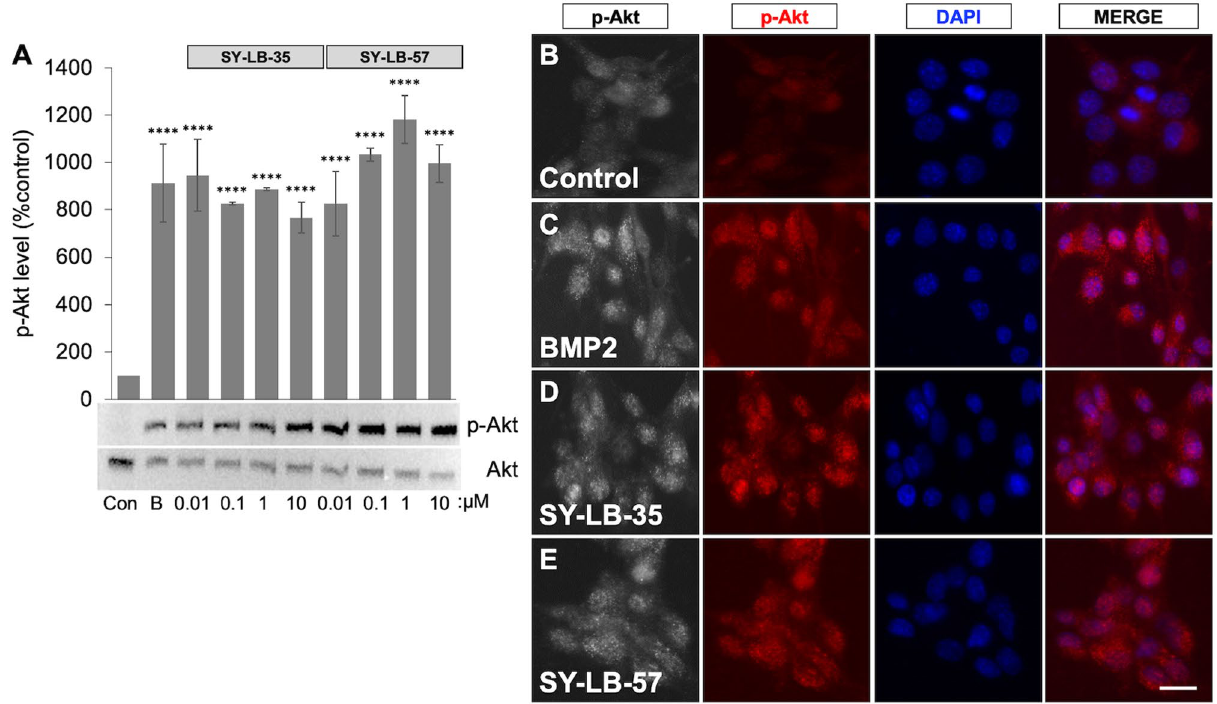
Figure 6. Phosphorylation and cytoplasmic distribution of p-Akt induced by SY-LB-35 and SY-LB- 57. (A ) Western Blot analysis using anti-p-Akt and anti-total Akt antibodies was performed on whole cell lysates of serum-starved C2C12 cells treated with 50 ng/mL BMP2 as a positive control, SY-LB-35 (0.01–10 µM) or SY-LB-57 (0.01–10 µM) for 15 min. Quantification of p-Akt levels with respect to control, untreated cells demonstrates that BMP2 (913%, **** p < 0.0005), SY-LB-35 (0.01 µM: 945%, 0.1 µM: 826%, 1 µM: 887%, 10 µM: 766%, **** p < 0.0005) and SY-LB-57 (0.01 µM: 827%, 0.1 µM: 1033%, 1 µM: 1181%, 10 µM: 995%, **** p < 0.0005) caused significant stimulation of Akt phosphorylation after 15 min in C2C12 cells. Levels of p-Akt were normalized to total Akt levels and are expressed as a percent of control (mean ± SEM; n = 3).